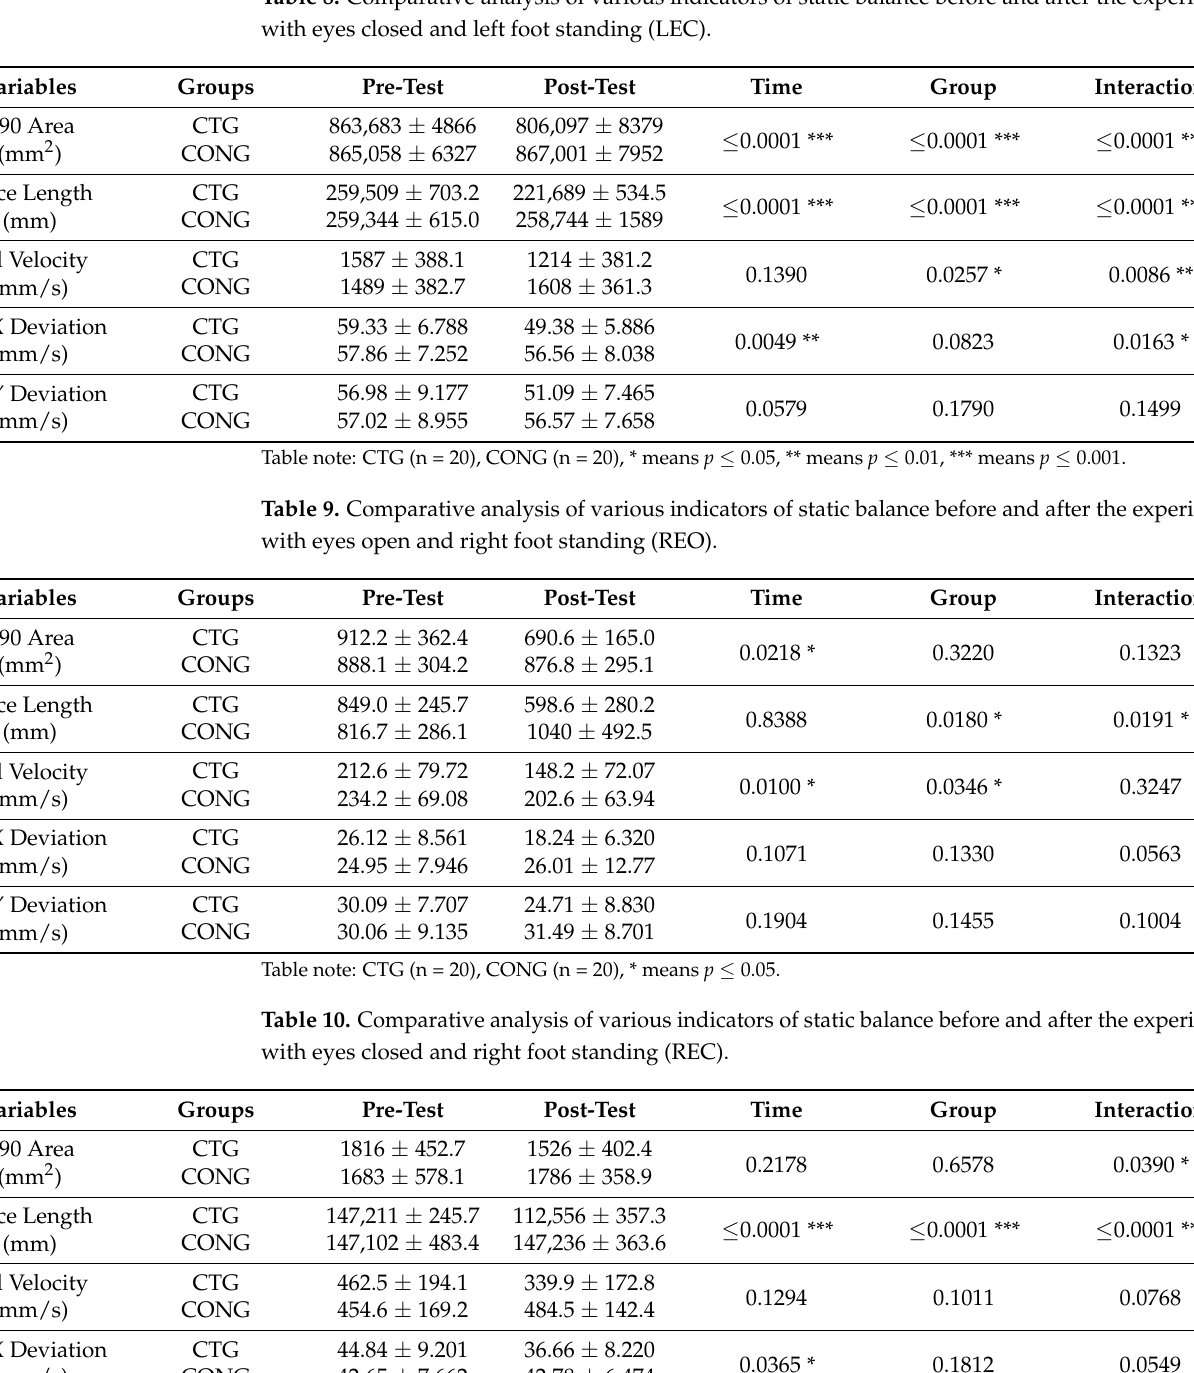
Table 8. Comparative analysis of various indicators of static balance before and after the experiment with eyes closed and left foot standing (LEC).